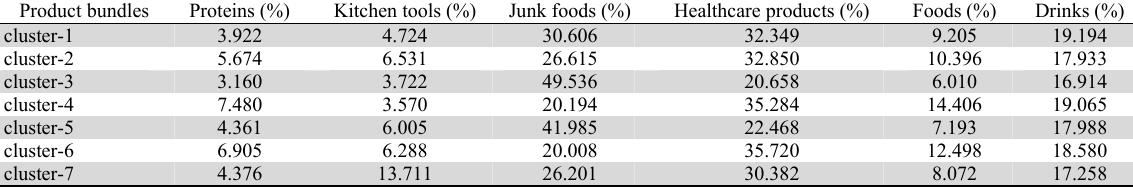
Percentages of product categories in each product bundle for scenario 1 in situation 1